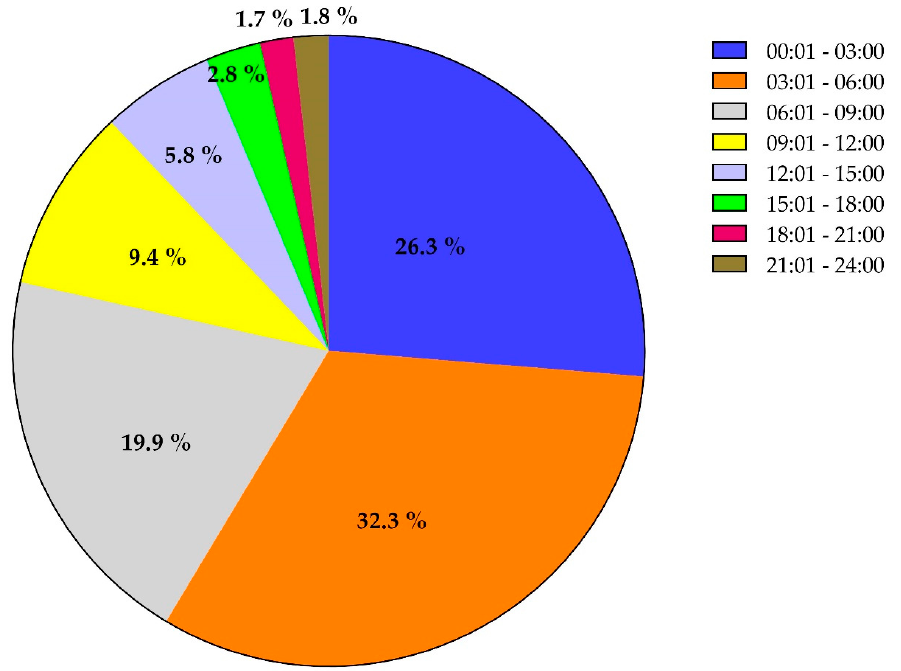
Figure 2. Analysis of time to ED presentation during the one-year period. The majority (almost 58%) of the patients were presented to the ED during 03:01–6:00 h (32.3%) and 00:01–3:00 h (26.3%). This was followed by time windows of 06:00–09:00 h (19.9%) and 09:01–12:00 h (9.4%), respectively.